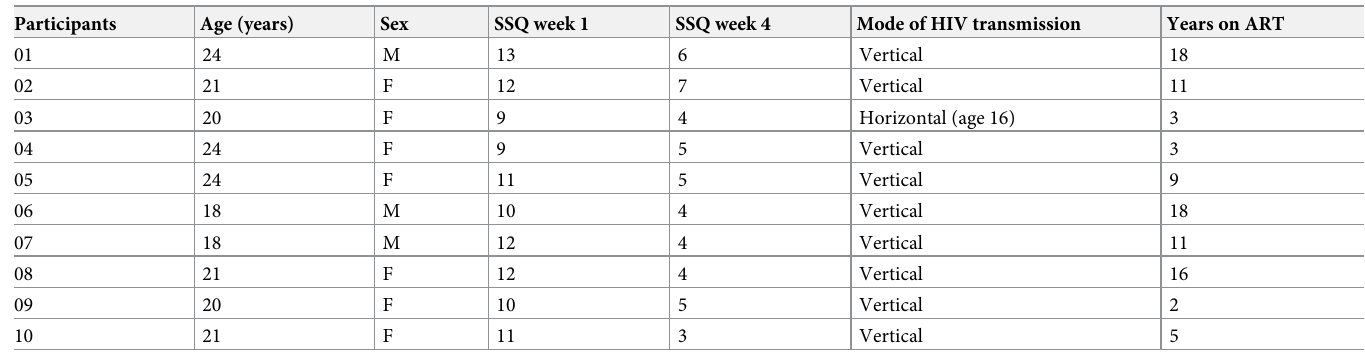
Table 1. Descriptive characteristics of the participants.